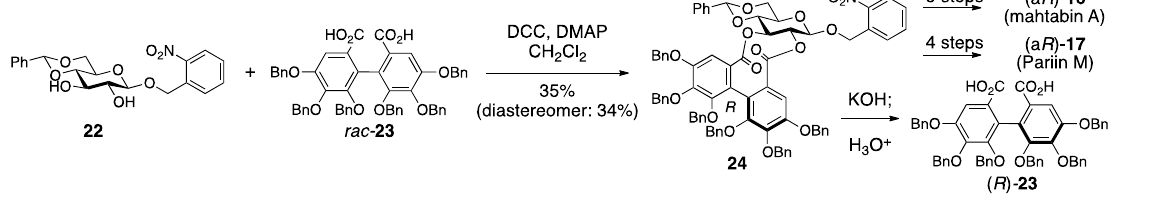
Figure 11. The synthesis of (a R )- 16 and (a R )- 17 .